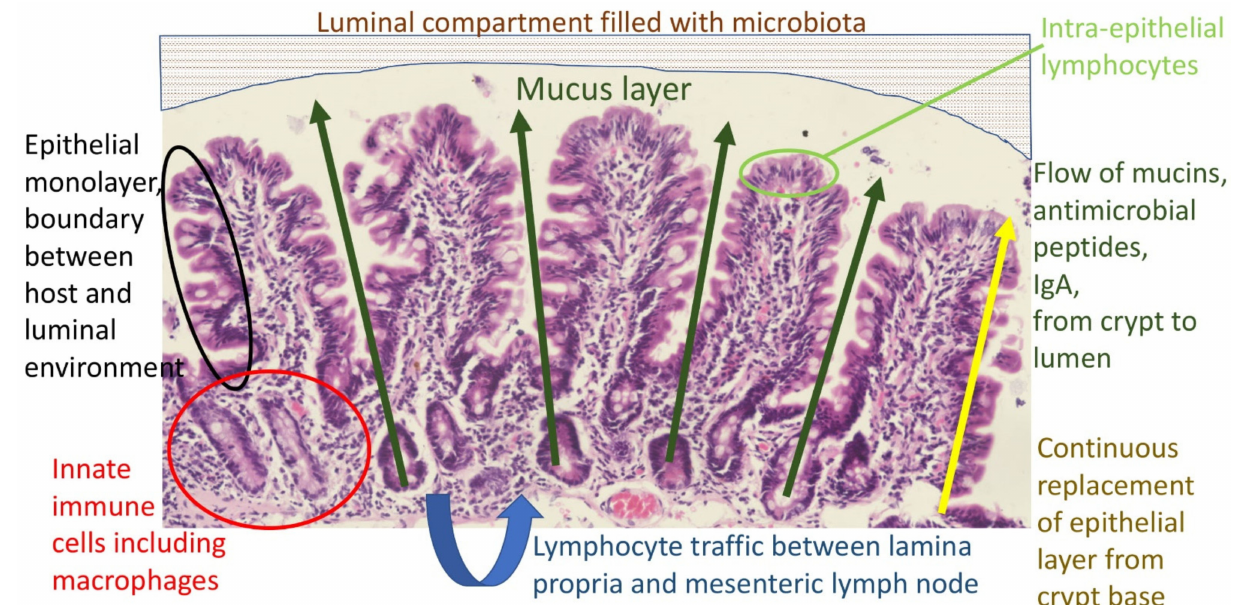
Figure 1. Major components of the mucosal barrier. The luminal stream is separated from the epithelium by the mucus layer, which is the physical substrate for a concentration gradient of antimicrobial molecules which acts as a repellent, protecting the stem cell compartment from microbial damage. The epithelium itself is the boundary between host and luminal environment, replaced entirely every 3–5 days and therefore dependent on proliferative drivers and repair factors. Organisms or their component molecules which traverse the epithelial boundary are then the target of innate and anamnestic immune